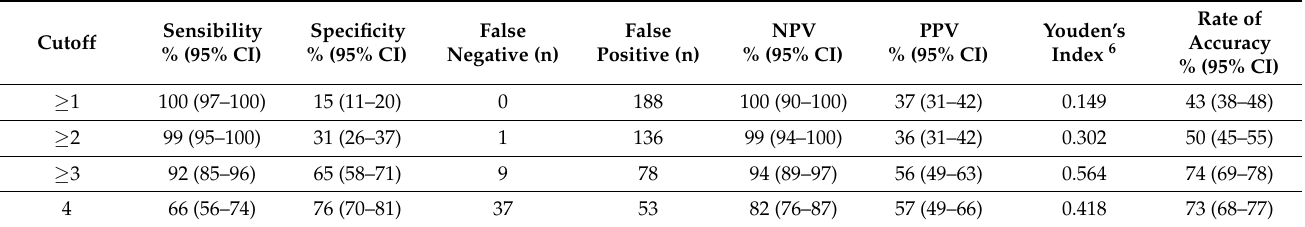
Table 3. Accuracy of the predictive score for the identification of CR-GNB sepsis, stratified by cutoff values of the score.